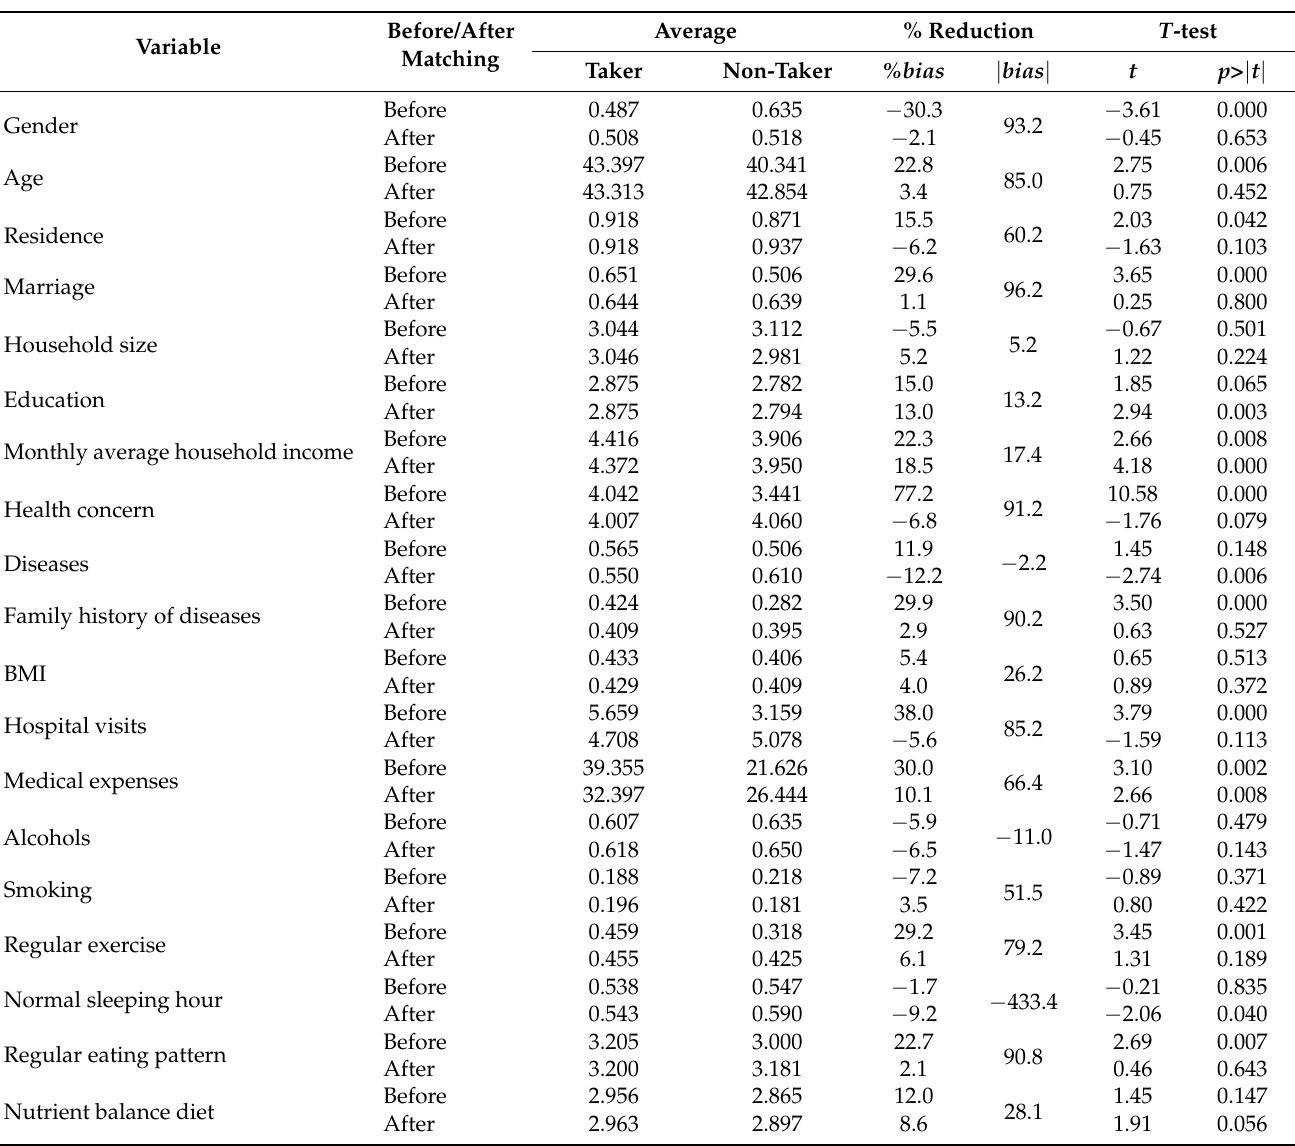
Table A1. Balance test results for covariates before and after matching (N–N